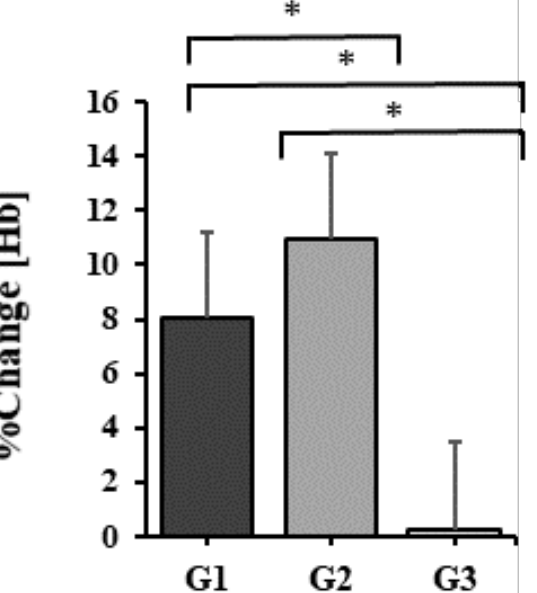
Figure 2. Relative before-after changes in Hb concentration after 30 days of training at 2000 m altitude (G1), living at 1850 m and training at 2200 m (G2), namely 300 m (G3). Values displayed represent mean ± sd. Significant differences (p < 0.05) between training courses are marked with *.